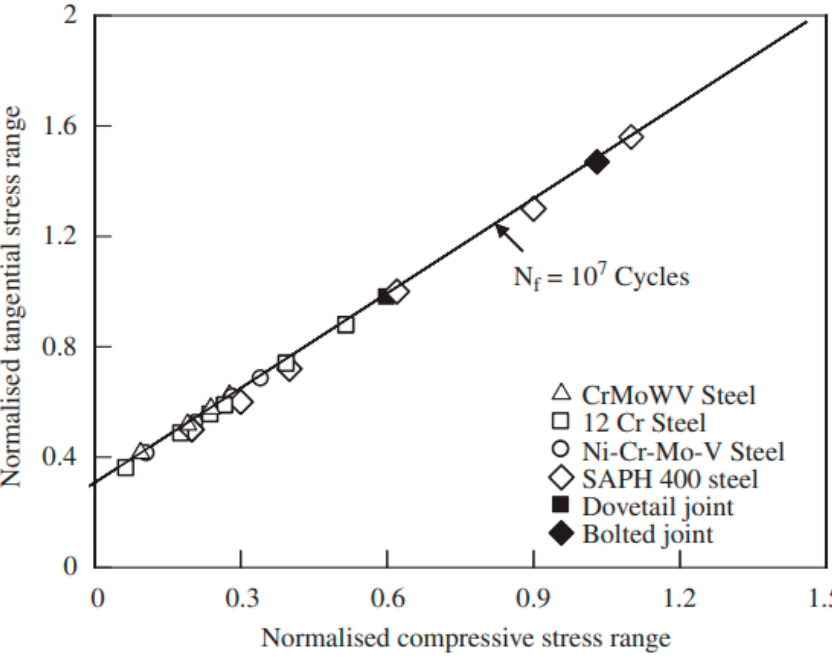
Figure 17. Generalized TSR-CSR diagram for various steels [117,118].